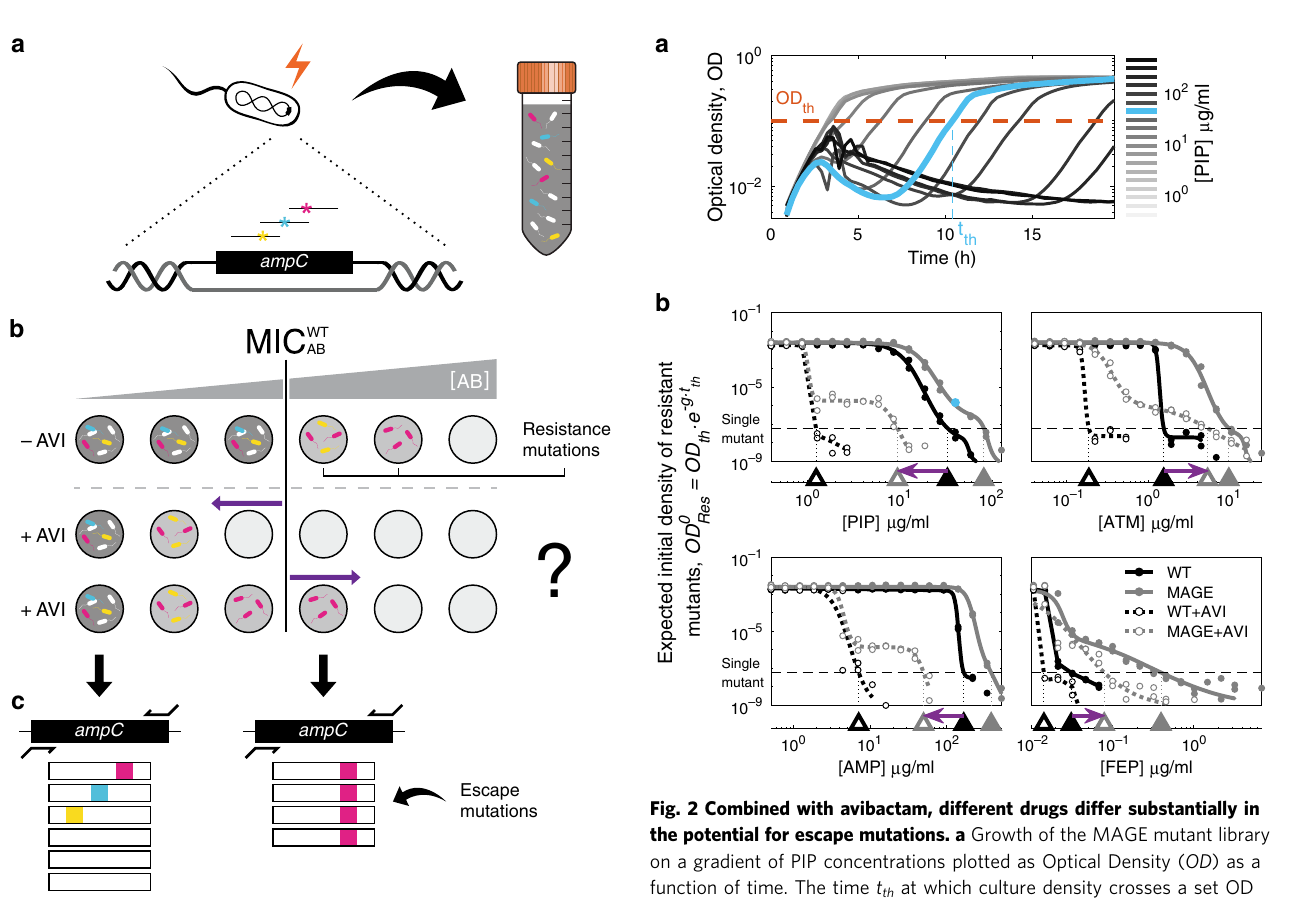
Fig. 1 Identi fi cation of escape mutations by site-directed mutagenesis followed by selection and sequencing. a The bla ampC gene of E. coli is mutated using MAGE technology to yield a mutant library of 790 different single amino-acid substitutions in the Bla ampC pocket. b The mutant library avibactam (AVI) and cell density is measured (Gray shade). At the